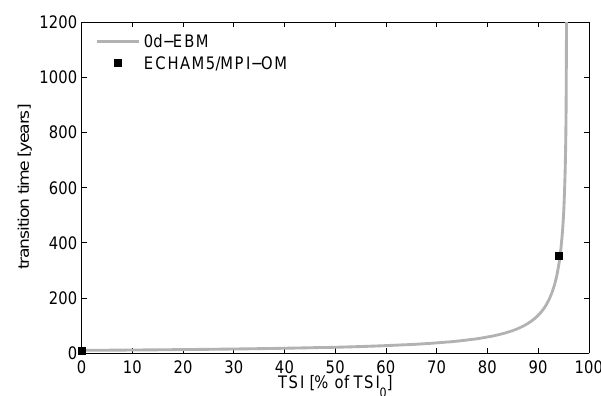
Fig. 7. Transition time to a Snowball Earth in dependence of to- tal solar irradiance as estimated by the linearized zero-dimensional energy balance model of global-mean ocean potential temperature (gray) and found by ECHAM5/MPI-OM (black squares). Total so- lar irradiance is given in percentage of the present-day value TSI 0